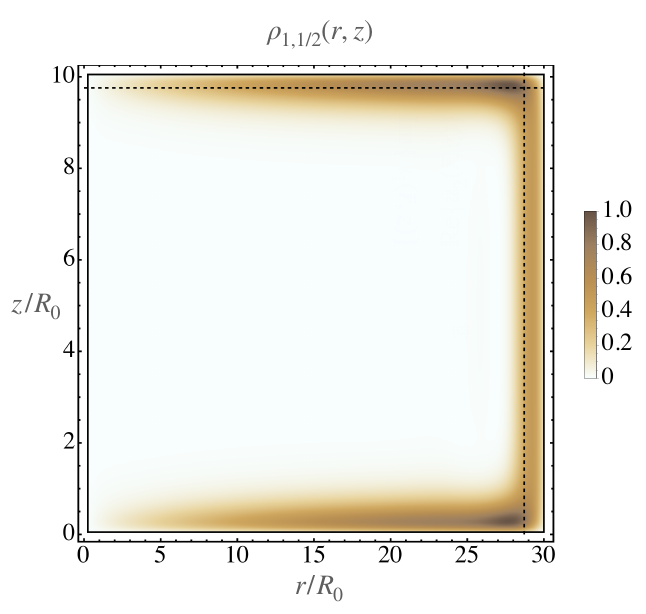
Figure 3: Probability density, scaled so that its maximum value is 1, for the state with n = 1 and j = 1 / 2 for R = 30 R tight-binding model with discretisation constants a expected, the surface state extends over the entire surface of the cylinder. The vertical dashed line is located at r = ¯ r = R − R position of the peak of the probability density on the side of the cylinder (away from the bases). The horizontal dashed line is located at z = z close to the peak near the top